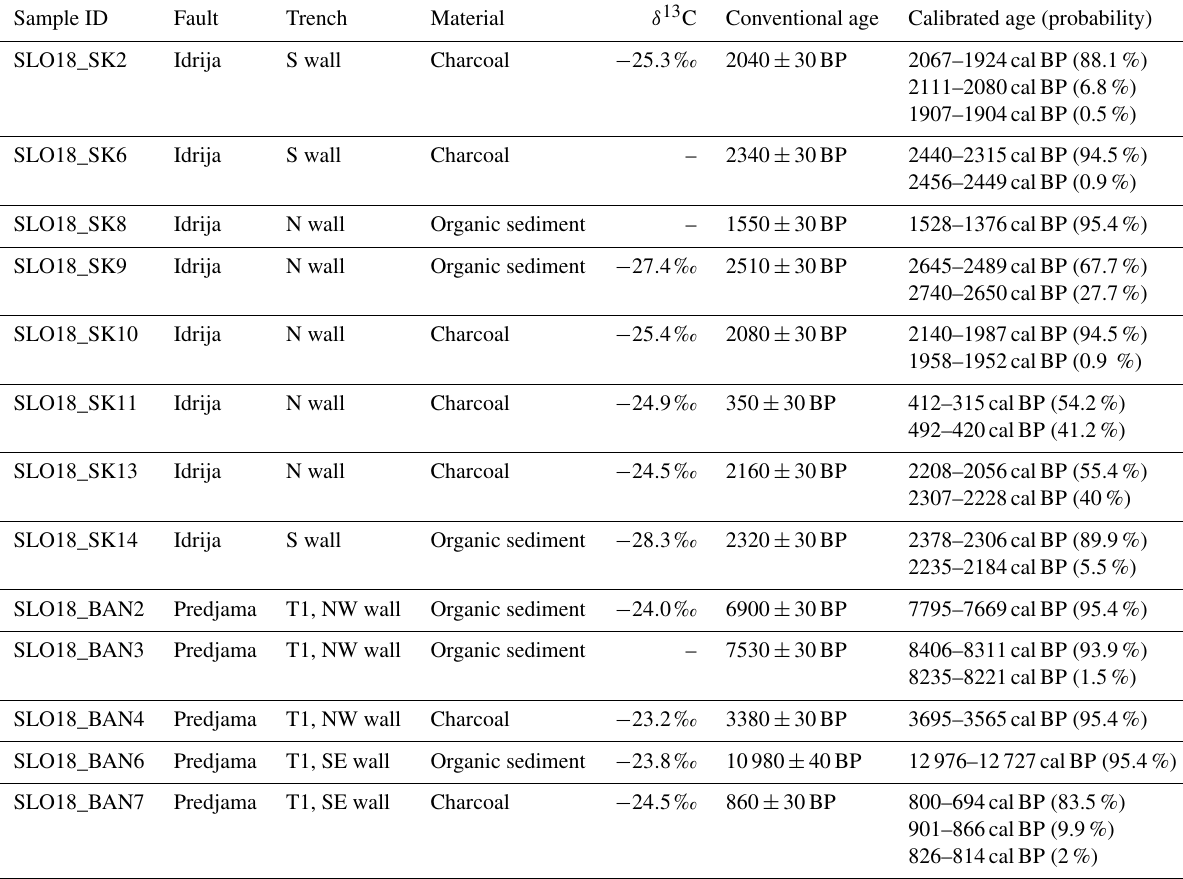
Table 1. Summary of all dated samples. Probability was calculated after Bronk Ramsey (2009). Calibration was done with INTCAL13 (Reimer et al.,